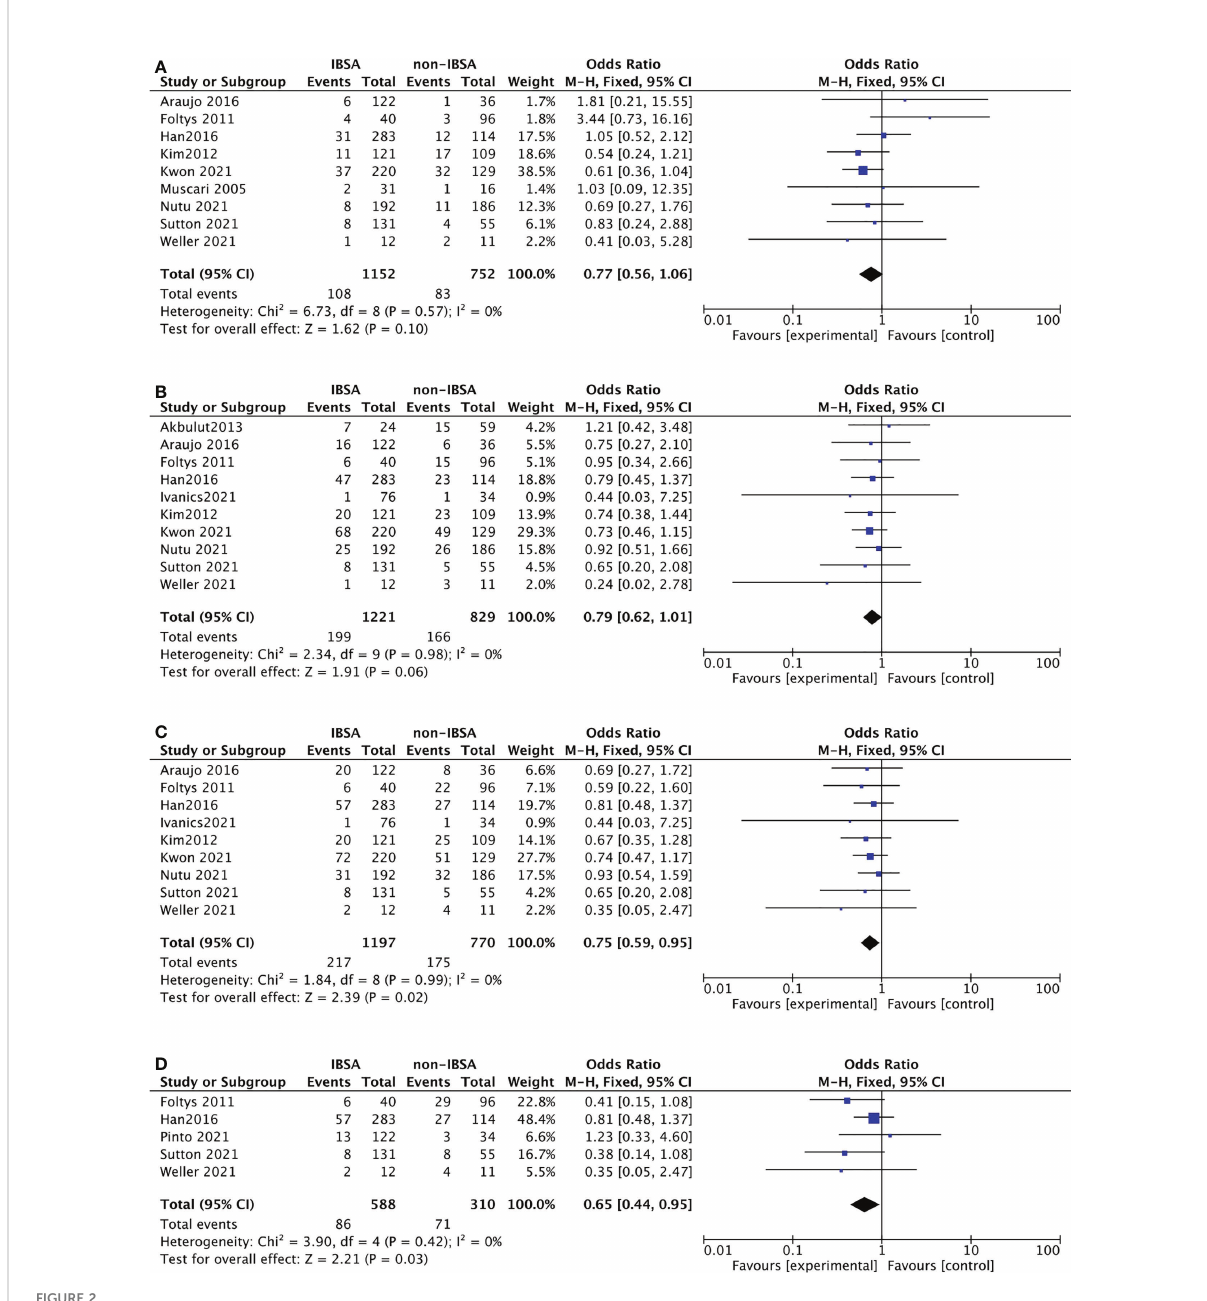
FIGURE 2 Meta-analysis forest plot of the recurrence rate. (A) , 1-year RR; (B) , 3-year RR; (C) , 5-year RR; (D) , 7-year